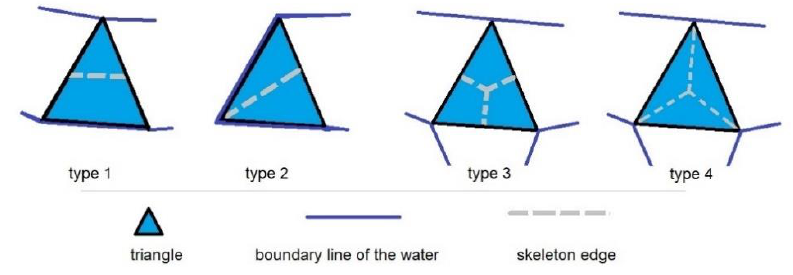
Figure 1. Triangle types: type 1 — link triangle, type 2 — ear triangle, types 3 and 4 — branch triangles.